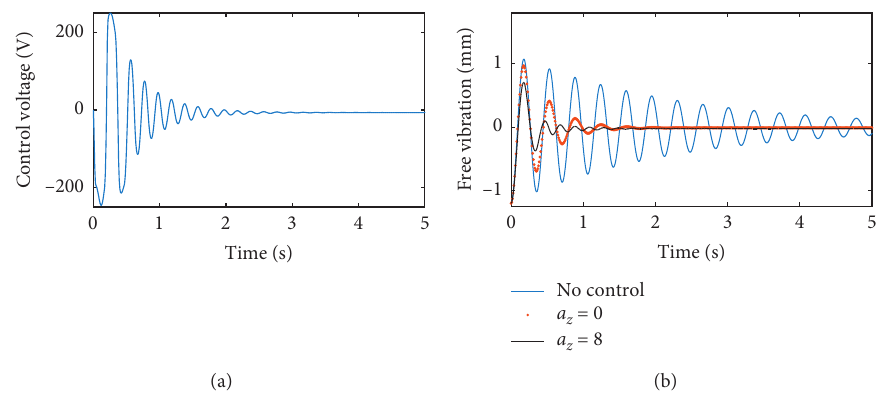
Figure 7: Control result at a